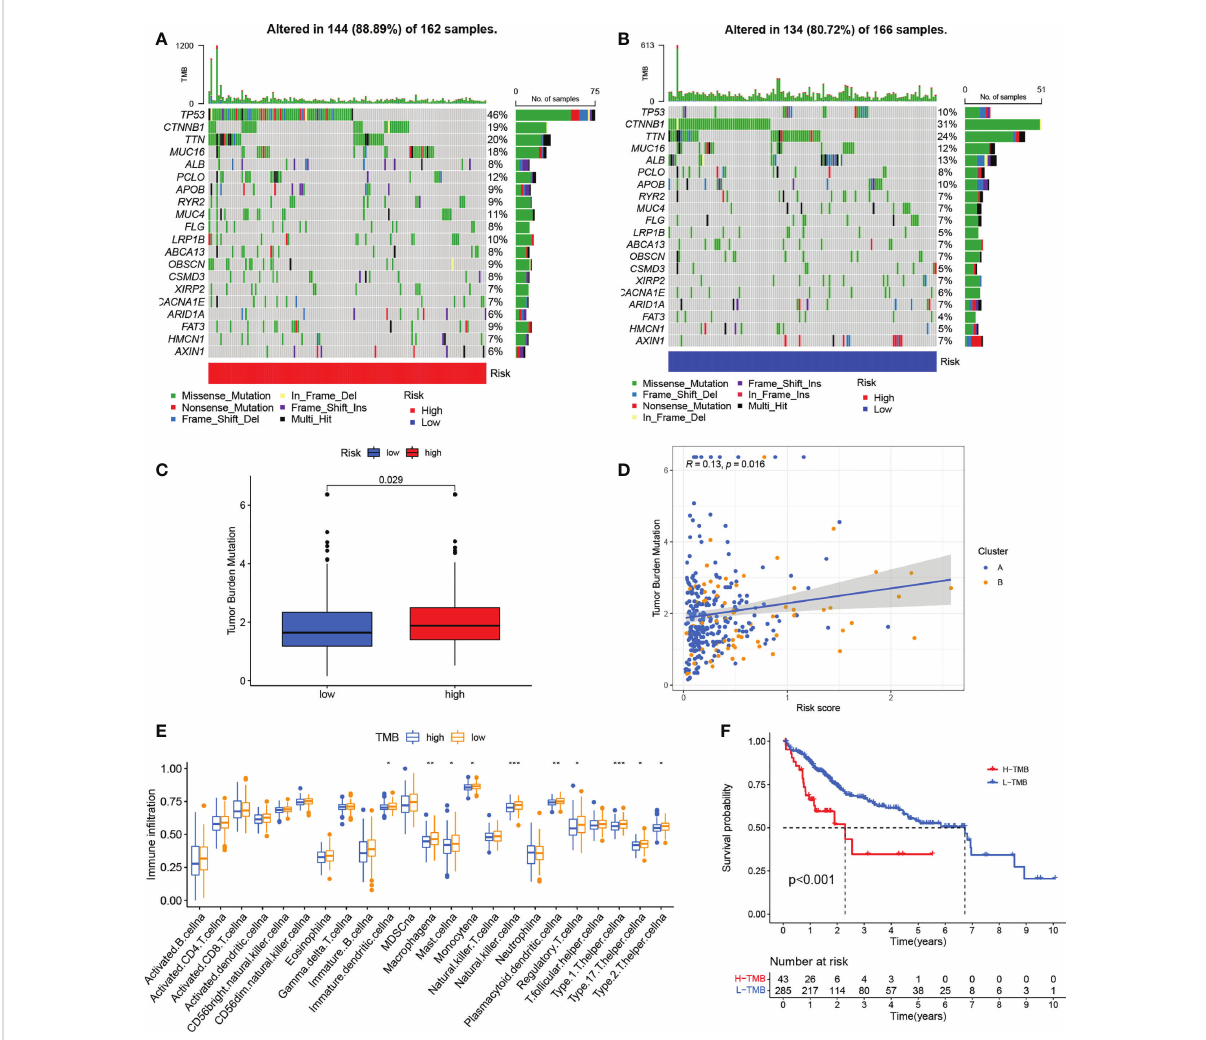
FIGURE 8 Associations between risk signatures and gene mutations. (A, B) Mutation frequencies in the groups with high and low risk (C) TMB values in the groups with high and low risk (D) Association between risk scores and TMB. (E) In fi ltration of immune cell in the groups with high and low TMB. (G) K-M curves for OS in the groups with high and low TMB. *P < 0.05; **P < 0.01; ***P < 0.001. TMB, tumor mutational burden; K-M,